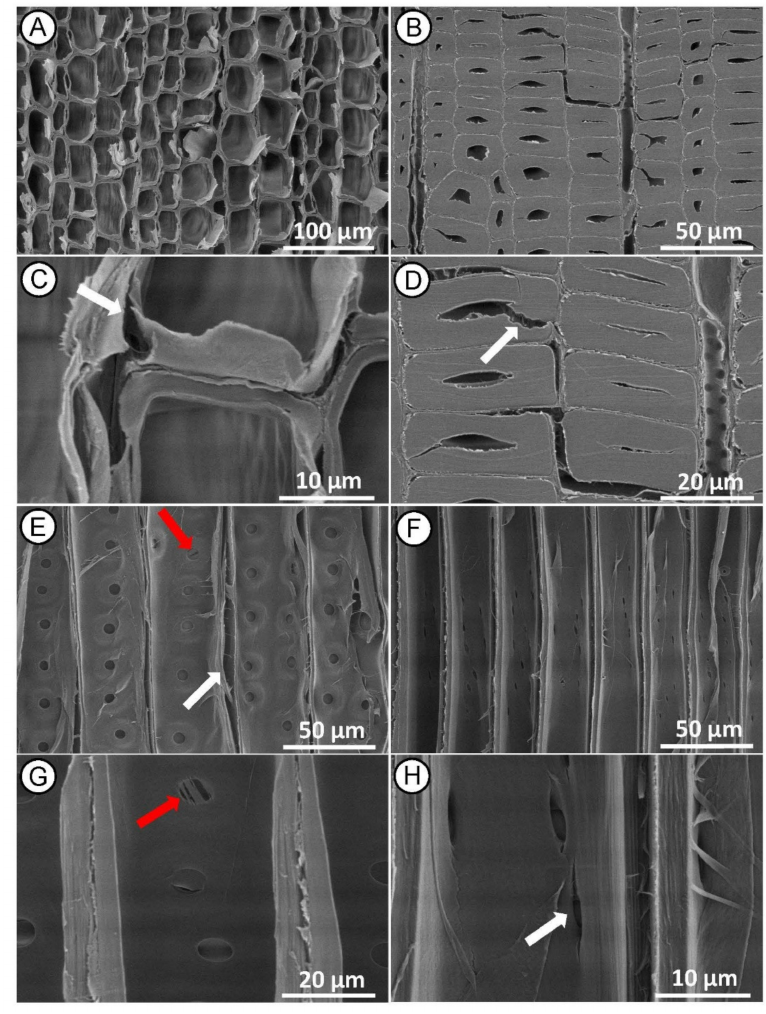
Figure 7. SEM micrographs of Norway spruce sapwood after HI MW treatment. Cross section showing collapsed tracheids in earlywood (( A , C )—white arrow) and partly damages tracheids in latewood (( B , D )—white arrow). Radial section showing deformation in longitudinal tracheids (( E )— white arrow), bordered pits with damage to the pit membrane on the tracheid walls (( E , G )—red arrows) and crakes in cross-field pits propagated from the poles (( F , H )—white